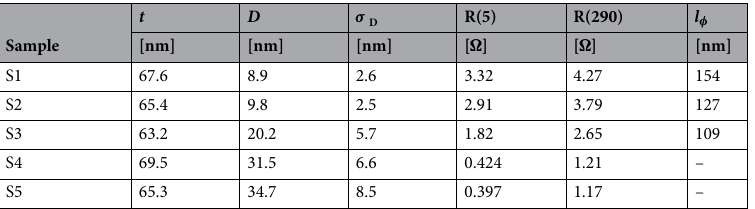
Table 1. Morphological parameters of the Cu films deposited onto mica substrates. t is the film thickness. The histogram describing the grain size distribution of each sample (measured with an AFM), was fitted to a Gaussian distribution having an average grain diameter D and a standard deviation σ D , using a set of images of over 1000 grains on samples S1, S2, S4 and S5, and a set of images of 655 grains on S3. R(5) is the resistance of the sample measured at 5 K; R(290) is the resistance of the sample measured at 290 K; l φ is the phase coherence length obtained from fits using the HLN model.